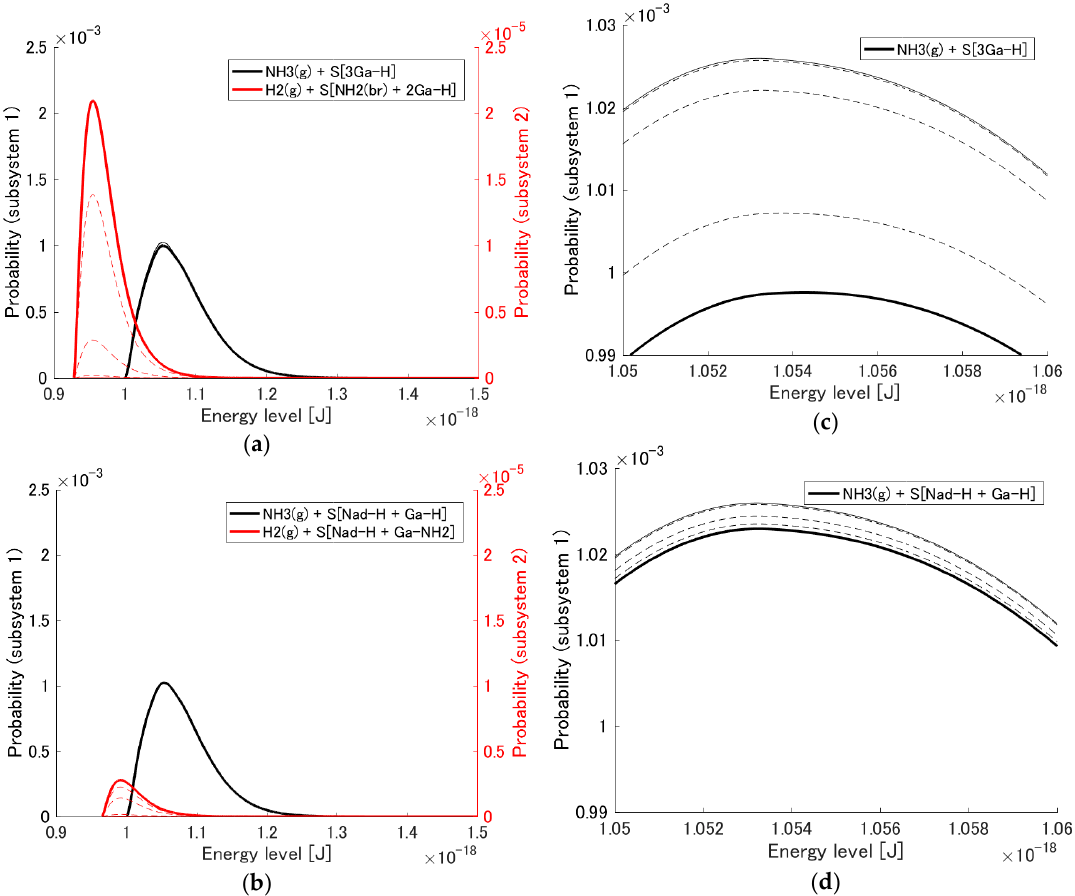
Figure 2. Probability distribution among the energy eigenlevels for the adsorption reactions on ( a ) S[3Ga-H] (and ( c ) zoomed-in) and ( b ) S[N ad -H + Ga-H] (and ( d ) zoomed-in). The narrow solid, dashed, and bold solid lines correspond to the initial state, a number of intermediate states during relaxation, and the stable equilibrium state, respectively.